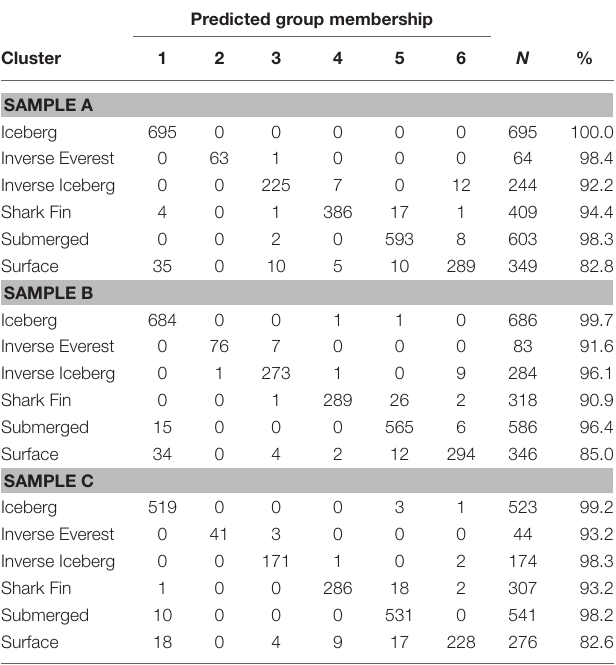
TABLE 7 | Classifications for Sample A ( n = 2,364), Sample B ( n = 2,303), and Sample C ( n = 1,865).